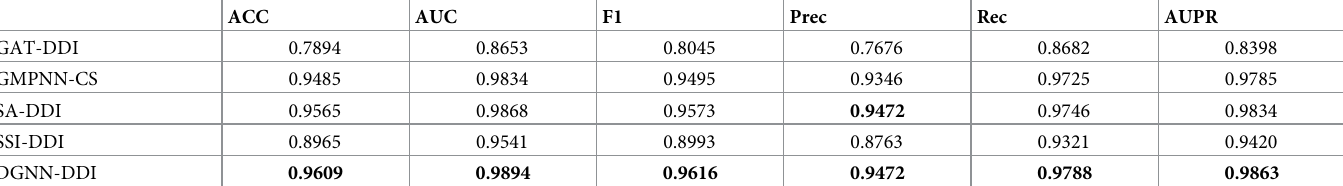
Table 1. Comparison results in % of the proposed DGNN-DDI and baselines on the dataset.